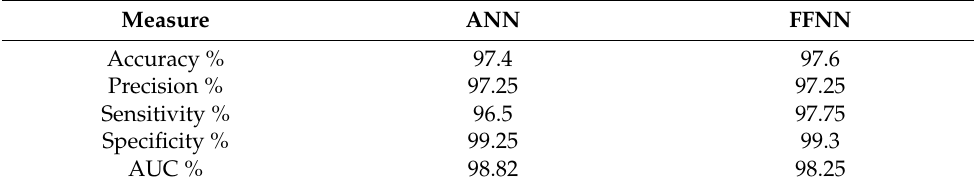
Table 2. The results of the ANN and FFNN algorithms on the gastroenterology dataset.